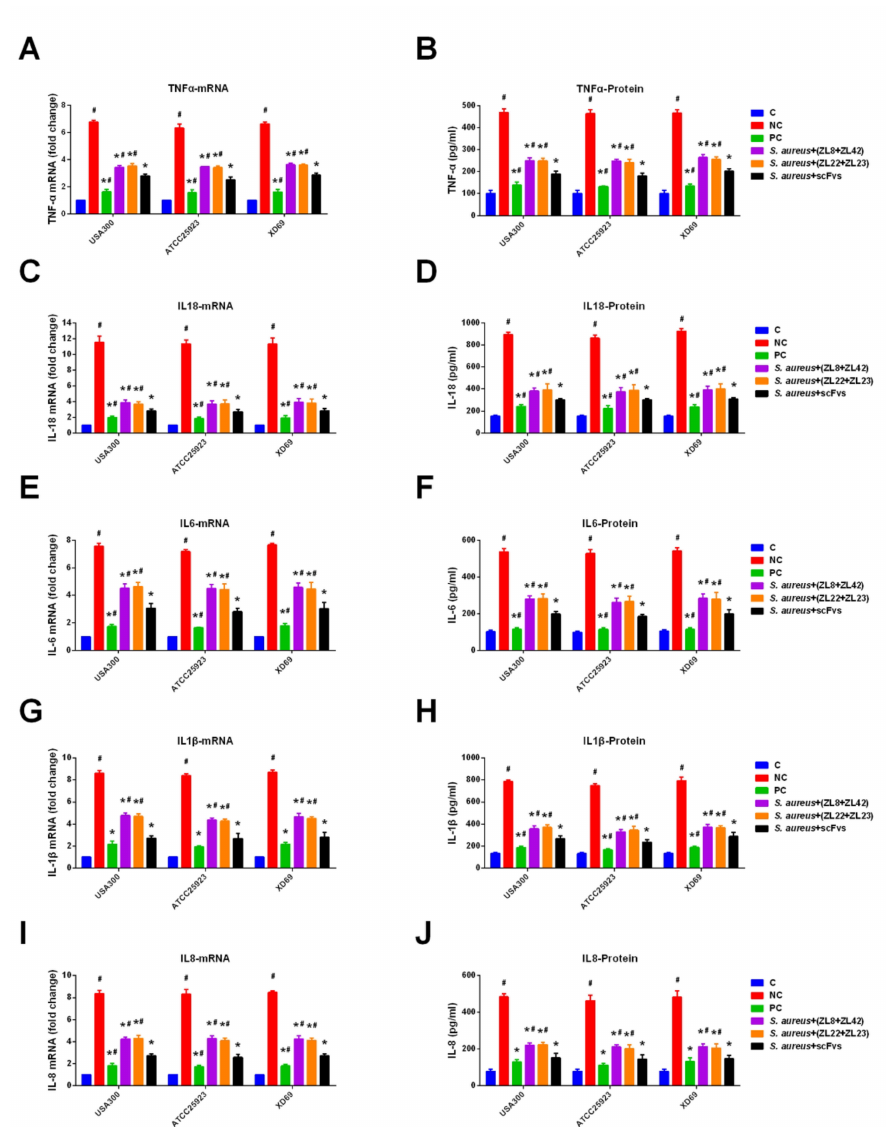
Figure 8. The effect of scFvs on the production of five pro-inflammatory cytokines in mammary gland tissues. ( A , C , E , G , I ) The transcription levels of TNF- α , IL-18, IL-6, IL-1 β and IL-8 in mammary gland tissues infected by three strains, respectively. ( B , D , F , H , J ) The expression level of TNF- α , IL-18, IL-6, IL-1 β and IL-8 in mammary gland tissues infected by three strains, respectively. GAPDH was used as the control gene. Data represent the mean results ± SD ( n = 6). # p < 0.05 vs. the scFvs mixture group. * p < 0.05 vs. the NC